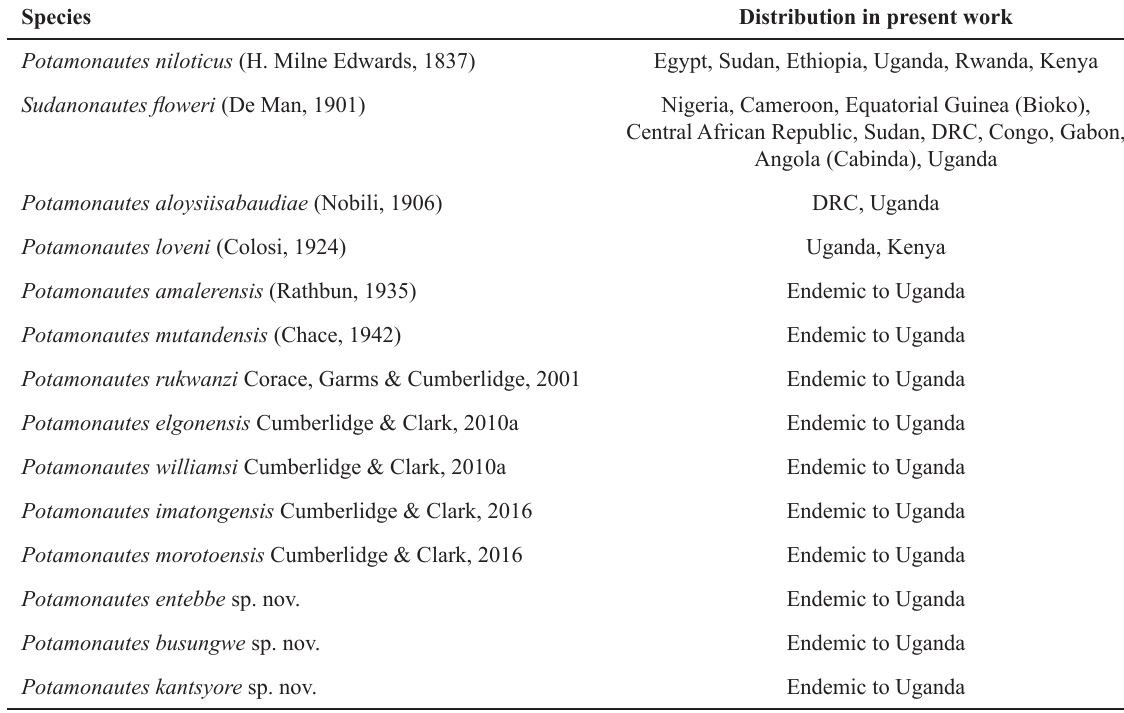
Table 1. Updated species list for Uganda recognized in the present work with the updated geographical distribution by country.